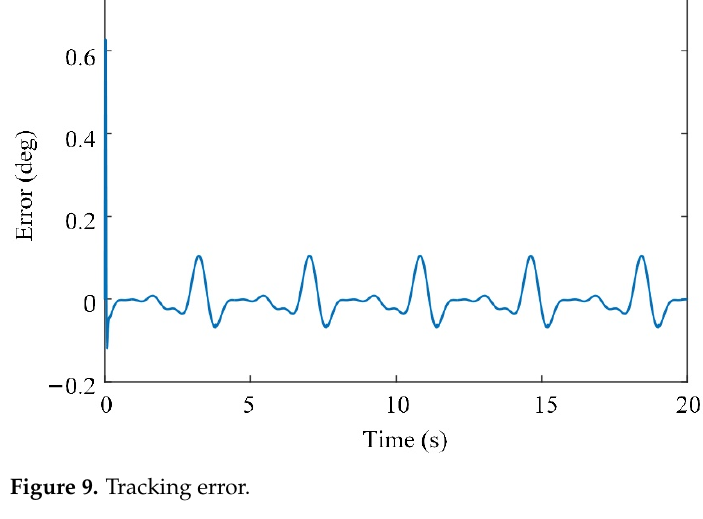
12 of 16 Figure 7. The control diagram. The input trajectory, tracking error, and generated joint torque of the system are shown in Figures 8–10, respectively. The initial tracking error exists. The simulation re- sults show that the tracking error of the system can be controlled within a certain range by using the adaptive controller to compensate for the uncertainty of the model, and the system has uniformly bounded stability. The designed controller can realize the motion control of the knee joint exoskeleton.